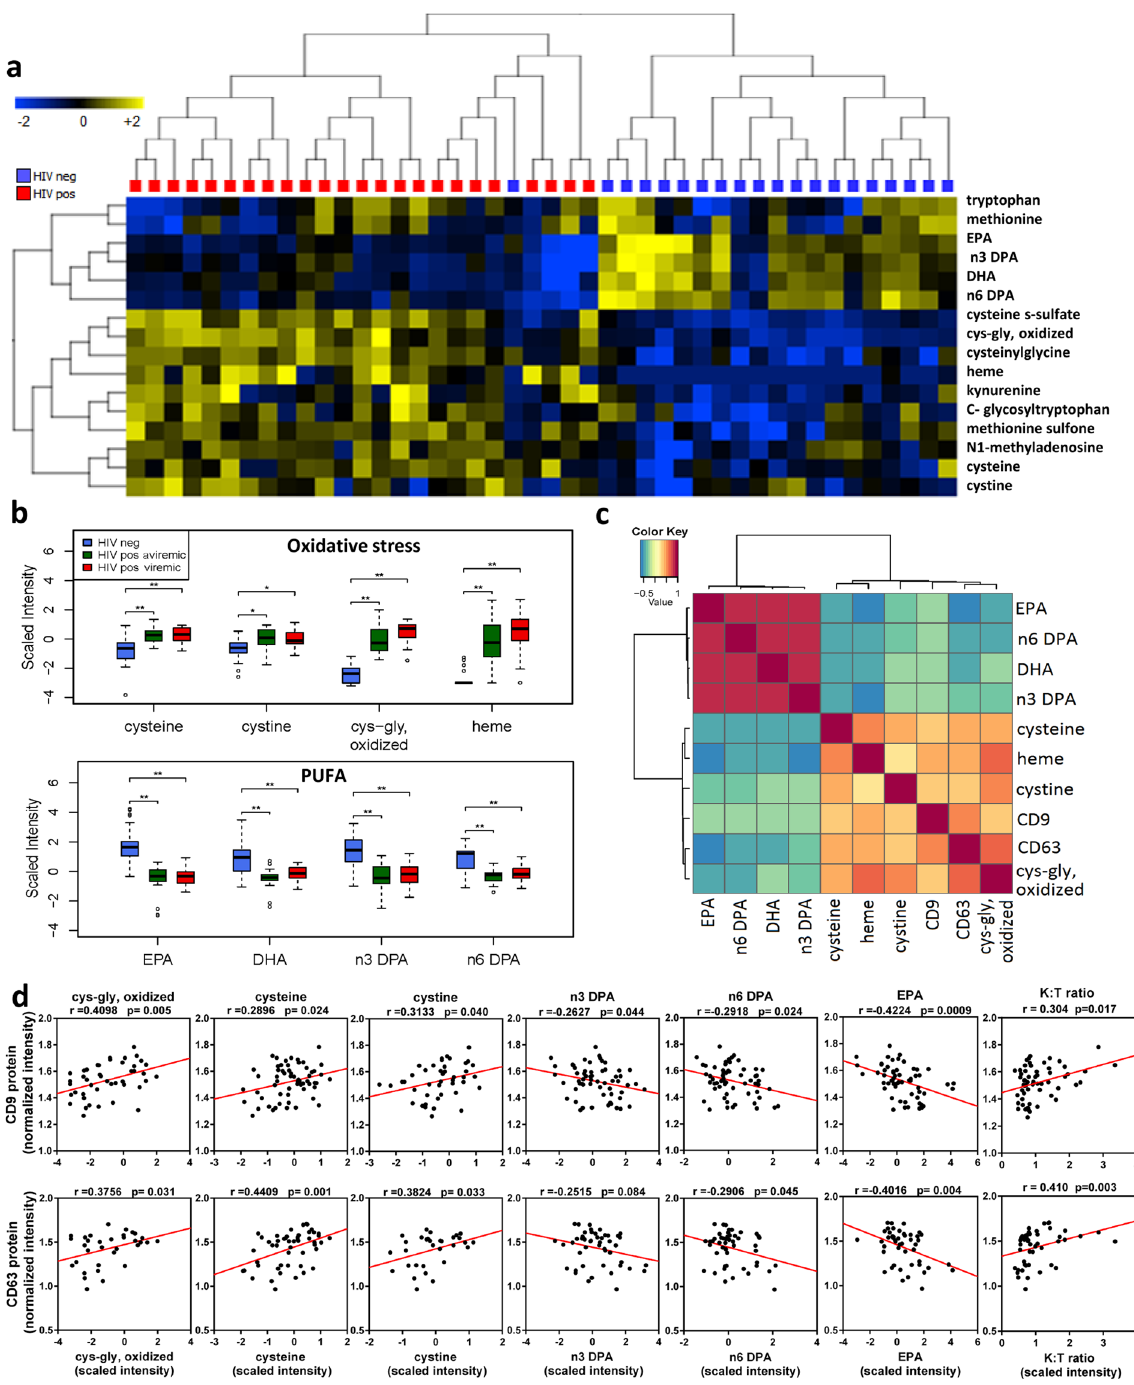
Figure 3. Exosome markers correlate positively with oxidative stress-related metabolites and negatively with levels of n-3 and n-6 polyunsaturated fatty acids. ( a ) Heatmap shows unsupervised hierarchical clustering of metabolites (n = 16) associated with oxidative stress, tryptophan catabolism, and polyunsaturated fatty acid (PUFA) metabolism that distinguish HIV-positive from HIV-negative control subjects (FC > 1.3, p < 0.05, FDR < 0.10). ( b ) Metabolites associated with oxidative stress are increased, and the indicated PUFA are decreased in aviremic and viremic HIV-positive subjects versus controls ( * p < 0.01, ** p < 0.001). Medians represented by horizontal bars, boxes span the IQR, and whiskers extend to extreme data points within 1.5 times IQR. Outliers are plotted outside 1.5 times the IQR. P-values calculated by Welch’s t-test (p < 0.05; n = 26 HIV- negative, n = 21 HIV-positive aviremic, n = 16 HIV-positive viremic subjects). ( c ) Pearson correlation matrix r-values show positive correlation of exosome marker proteins (CD9 and CD63) with metabolites associated with oxidative stress, and negative correlation with n-3 and n-6 PUFA (p < 0.05). ( d ) Correlation scatter plots are shown with correlation coefficients and p-values above each plot. n = 36 HIV-positive, 26